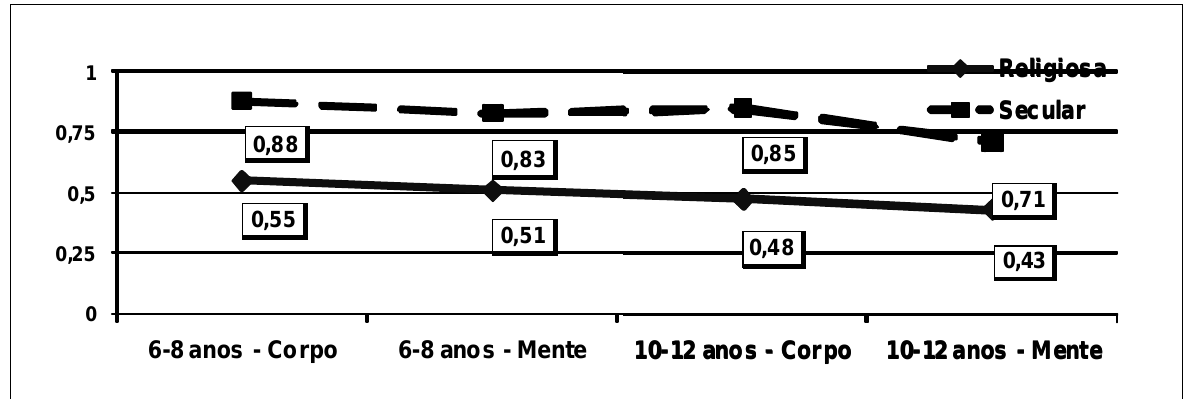
Figura 2 . Média das justificativas biológicas em função da Idade, Narrativa (Secular versus Religiosa) e Tipo de Processo (Corpo versus